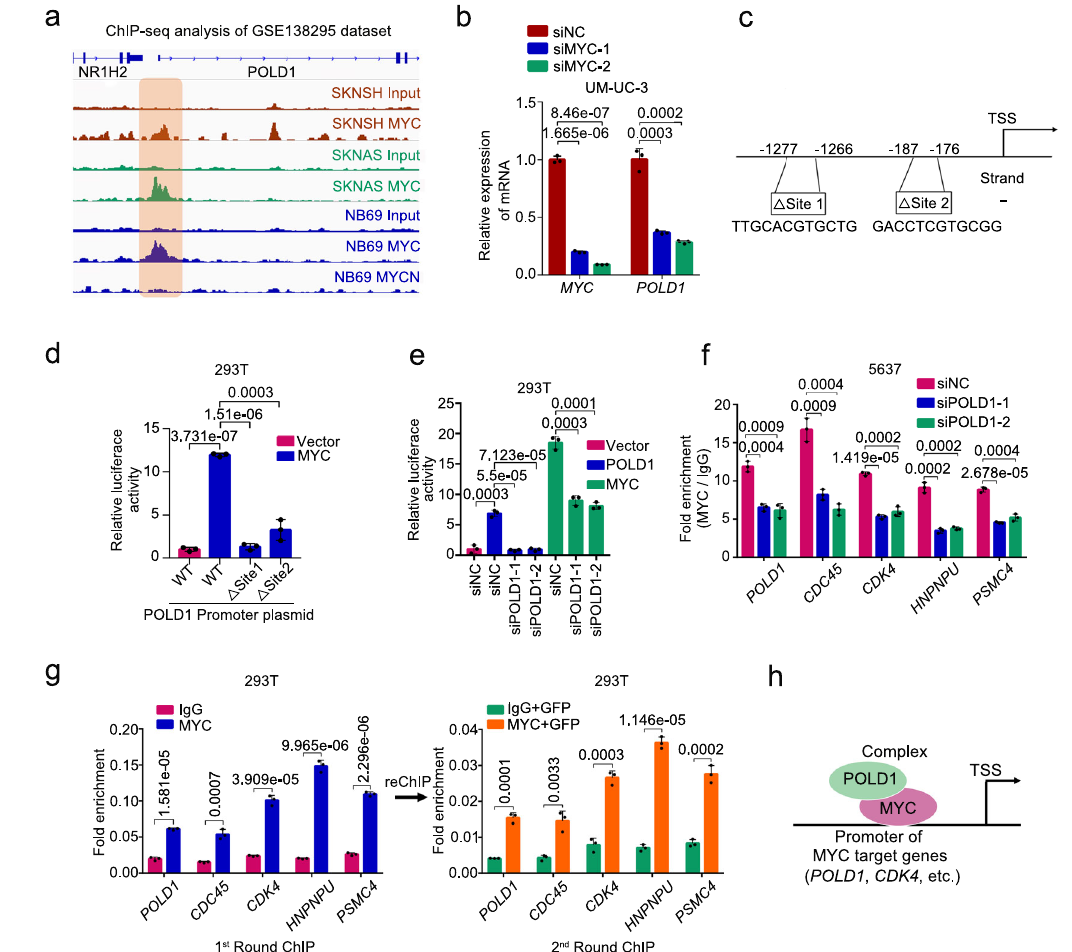
Fig. 7 | POLD1affectsthetranscriptionalactivityofMYCand is thetargetgene fortranscriptionalactivationofMYC.a GenomebrowsertracksofMYCorMYCN occupancy in the POLD1 loci in SKNSH, SKNAS or NB69 cells (public dataset: GSE138295 53 ). The genome browser map is displayed by IVG software. The brown region marks a region in the POLD1 promoter region where MYC is signi fi cantly enrichedrelativetoinput. b Effectsof MYC depletionon POLD1 transcriptionlevels in UM-UC-3 cells. c Schematic diagram of the two MYC binding sites in the POLD1 promoter region predicted by the JASPAR website. d Luciferase reporter assays of the POLD1 promoter in Vector, Flag-MYC, and WT POLD1 promoter or mutant POLD1 promoter ( △ Site 1 and △ Site 2)-overexpressing 293T cells. e Luciferase reporter activities of the POLD1 promoter were assessed in the presence of exo- genous MYC or POLD1 in POLD1 -depleted 293T cells. f ChIP-qPCR assays of